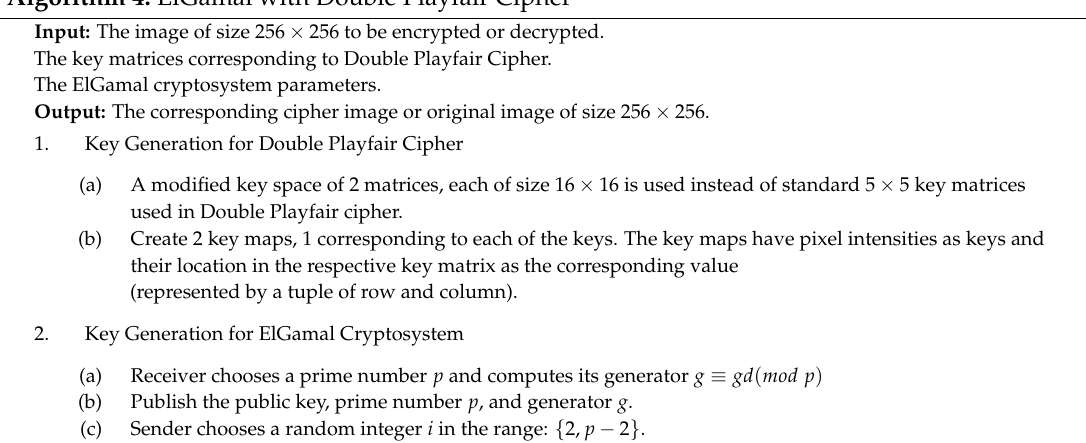
Algorithm 4: ElGamal with Double Playfair